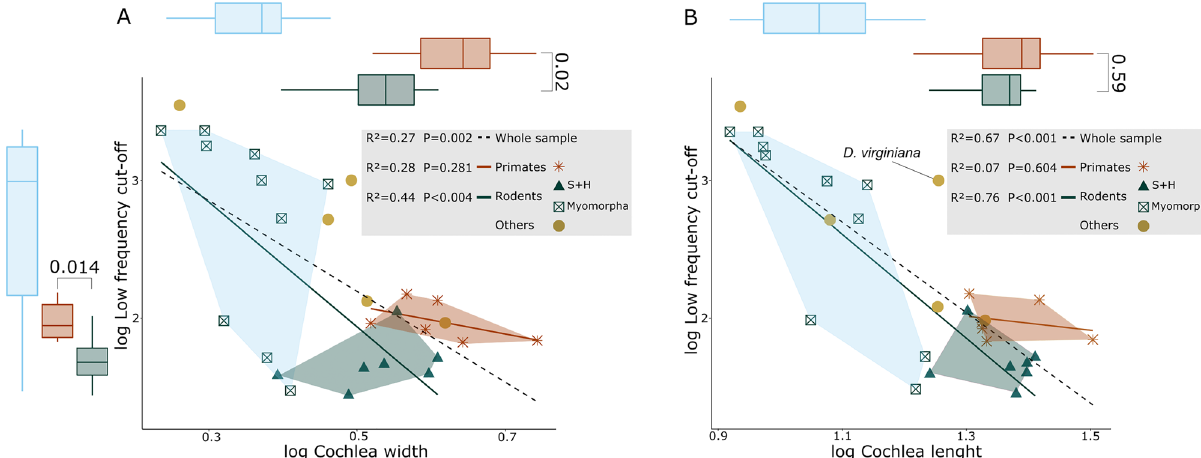
Figure 6. Selected scatterplots for low frequency cut-off. ( A ) Scatterplot of cochlea length and ( B ) cochlea width against low frequency cut-off with additional regression values for each separate group. Regression values were obtained by building PGLS models. On top of their respective plots, boxplots for cochlea length and cochlea width are displayed. The values plotted are Wilcoxon p-values, and show that no difference in length exists between rodents and primates, but a significant difference in width is present. S + H: Sciuromorpha and